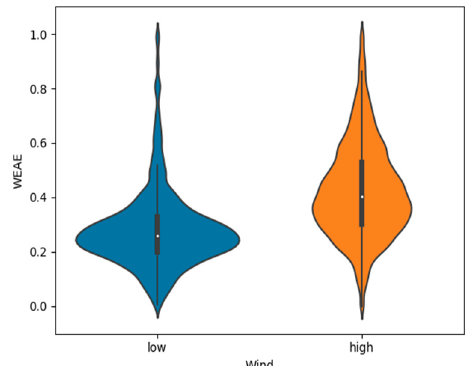
Figure 6. Comparison of WEAE distribution for all flight patterns and altitudes flown, with wind speed as discriminant factor. Low Wind conditions present high density of medium to low values of gas concentration measurements, while High Wind yields more evenly distributed ones and a higher average.